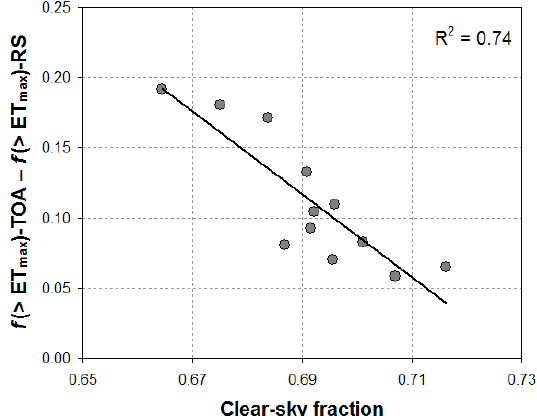
Figure 5. Correlation between all-site average monthly clear-sky fraction ( R s , d / R TOA , d ) and the difference between the overestima- tion frequency ( > ET max ) for TOA and RS methods.